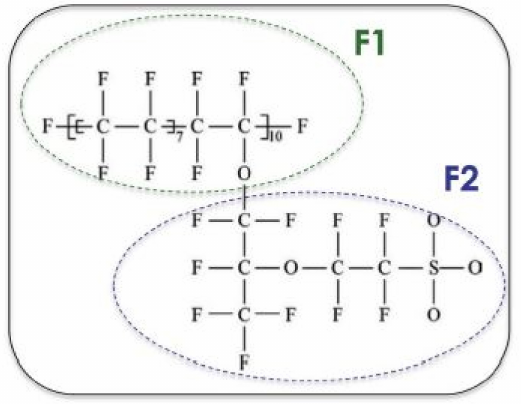
Figure 2. Structure of the Nafion membrane. F1 and F2 are the labels of fluorine atoms in the backbone and branching